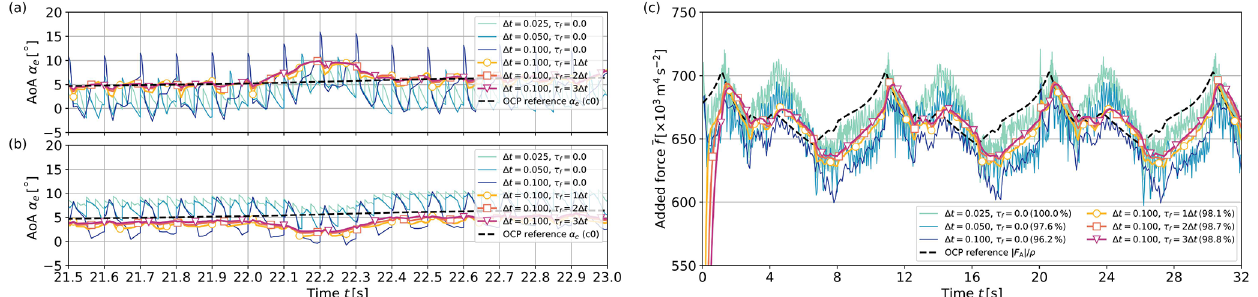
Figure A2. Instantaneous angle of attack monitored at the wing tip section on the port (a) and starboard (b) sides. (c) Magnitude of the specific forces f added to the flow field at the fourth stage of the LES Runge–Kutta scheme by means of actuator methods for different sets of parameters. Three ALM simulations are performed with different LES time steps, and three ASM simulations are performed with three different time filter constants. The black dashed lines show the OCP references.